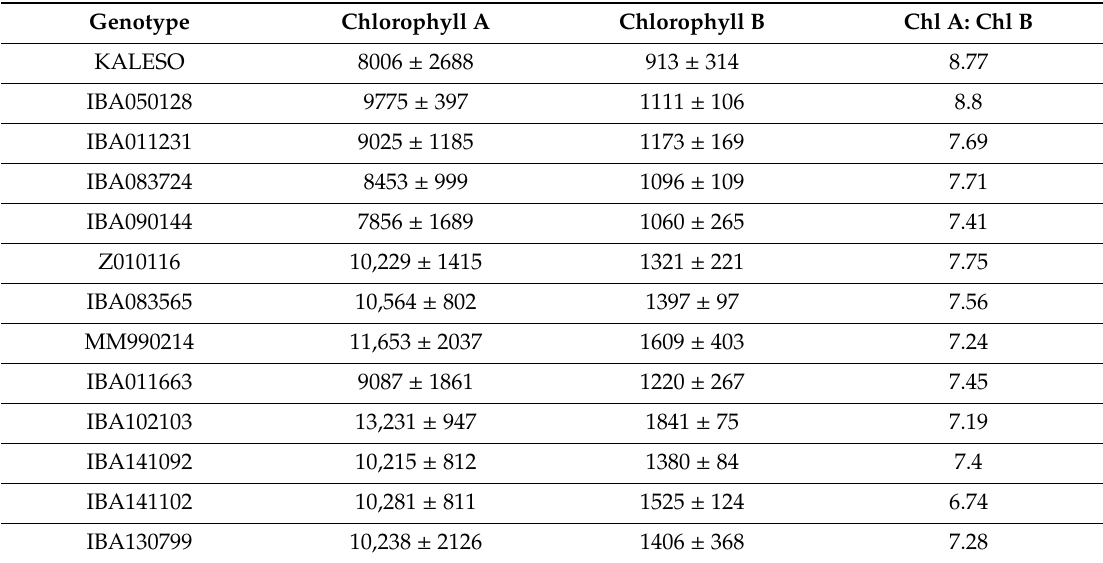
Table 3. Chlorophyll A and B composition in leaf samples ( µ g g − 1 ). Three plants per genotype were analyzed.